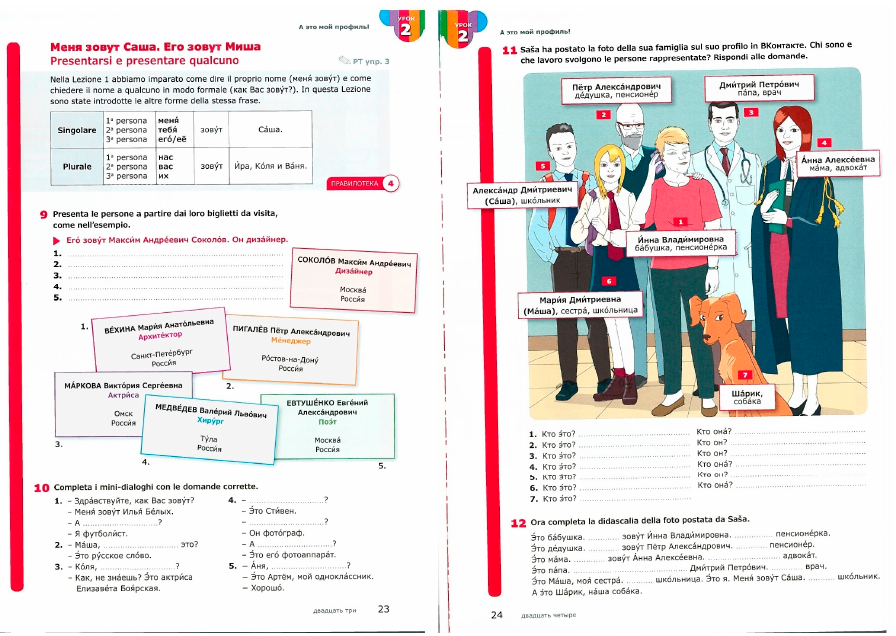
Figure 11. Example 1 of a task in Ura . The same is true for the restaurant order task in Figure 12 (Ibid.: II: p. 101), which contains related and interdependent activities (correcting mistakes and creating a dialogue in